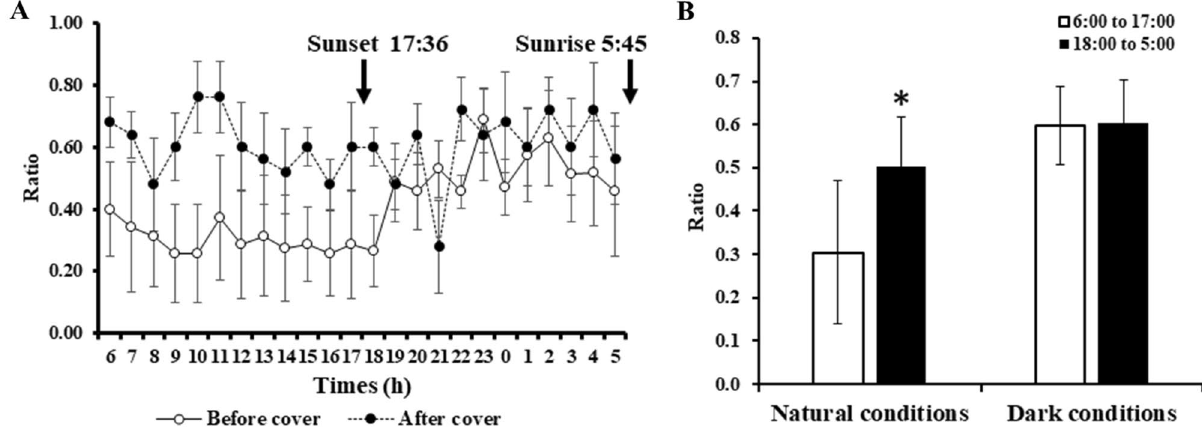
Figure 9. Influence of light prevention on the tentacle-thrusting behavior of Oligobrachia mashikoi in the inhabited seabed area. ( A ) Oligobrachia mashikoi was analyzed at each time point indicated to evaluate whether they thrusted tentacles from their tubes. The Y-axis presents the ratio of the number of times that tentacle- thrusting behavior was observed to the number of analyses (n = 5 to 8). The values are the mean ± S.E.M. of five independent experiments. Experiments were performed on September 24–October 6, 2021. Animals were covered with a case (Fig. S3C) to prevent them from being exposed to light during daytime on October 1–6, 2021 (black circle), while they were not covered on September 24–October 1, 2021 (white circle). The time of sunset and sunrise are indicated by their respective arrows. ( B ) The average values of the ratios of the number of times that tentacle-thrusting behavior was observed to the number of analyses at each of time point between 6:00 and 17:00 (white bar) or 18:00 to 5:00 (black bar) in ( A ) are described. The values are the mean ± standard error of the mean (S.E.M.) of five independent experiments. Animals were covered with a case from 1st to 6th October, 2021 (dark conditions), and not covered from 24th September to 1st October, 2021 (natural conditions). A paired t -test was performed to examine the statistical significance of the changes between daytime and nighttime in the same individuals. *p < 0.05.